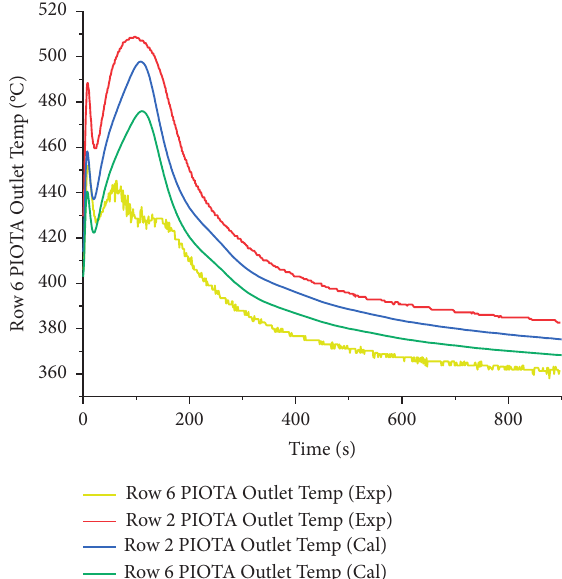
Figure 21: Row 2 and row 6 PIOTAs outlet temperature.